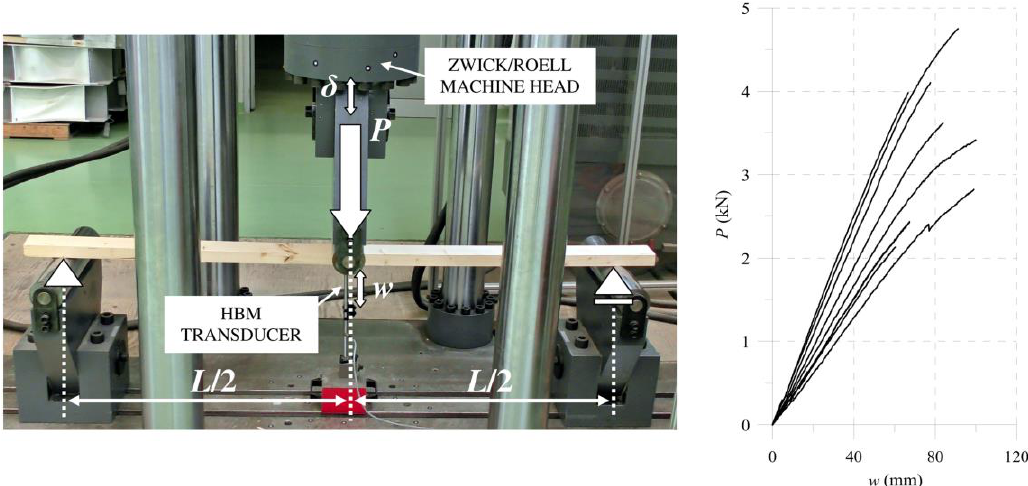
Figure 17. Laboratory setup and results.